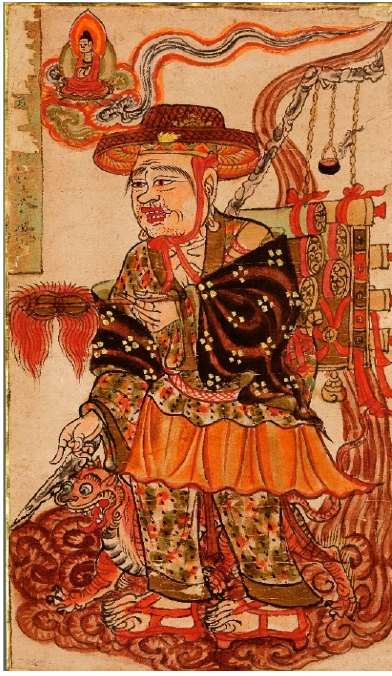
Figure 1. Itinerant Monk . Dunhuang, 10th century . Ink and colors on paper, 49.8 × 28.6 cm . National Museum of Korea.